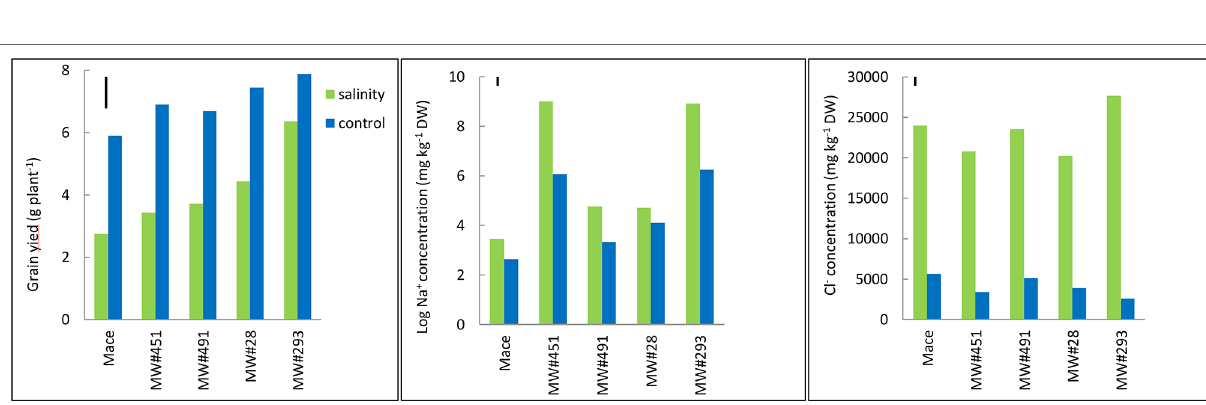
FIGURE 6 | Best linear unbiased estimates for grain yield, and leaf Na + and Cl - concentrations at heading in bread wheat cv. Mace, and two low-Na + (MW#28 and MW#491) and two-high Na + (MW#293 and MW#451) doubled-haploid lines selected from a cross between Mace and high-Na + germplasm W4909 (n = 5). Sodium concentration data were transformed to natural logarithms. The vertical bars indicate Least Significant Difference test value at P = 0.05 for variety x treatment interaction. Wheat lines are ordered in ascending order of salinity tolerance (ratio of grain yield under salinity to grain yield under control, expressed as